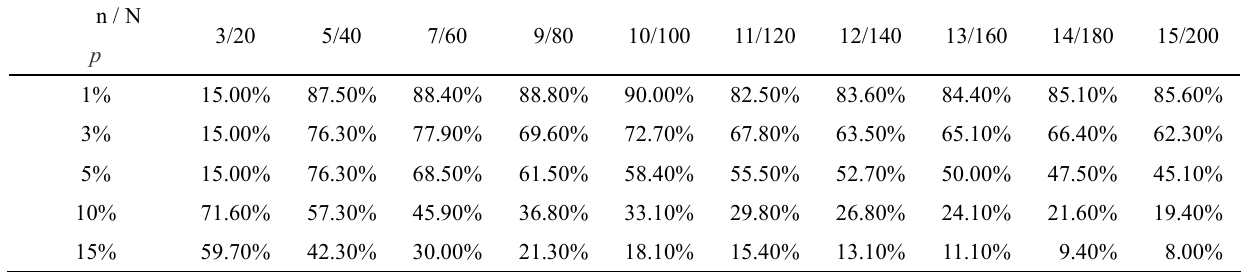
Table 1. Consumer's